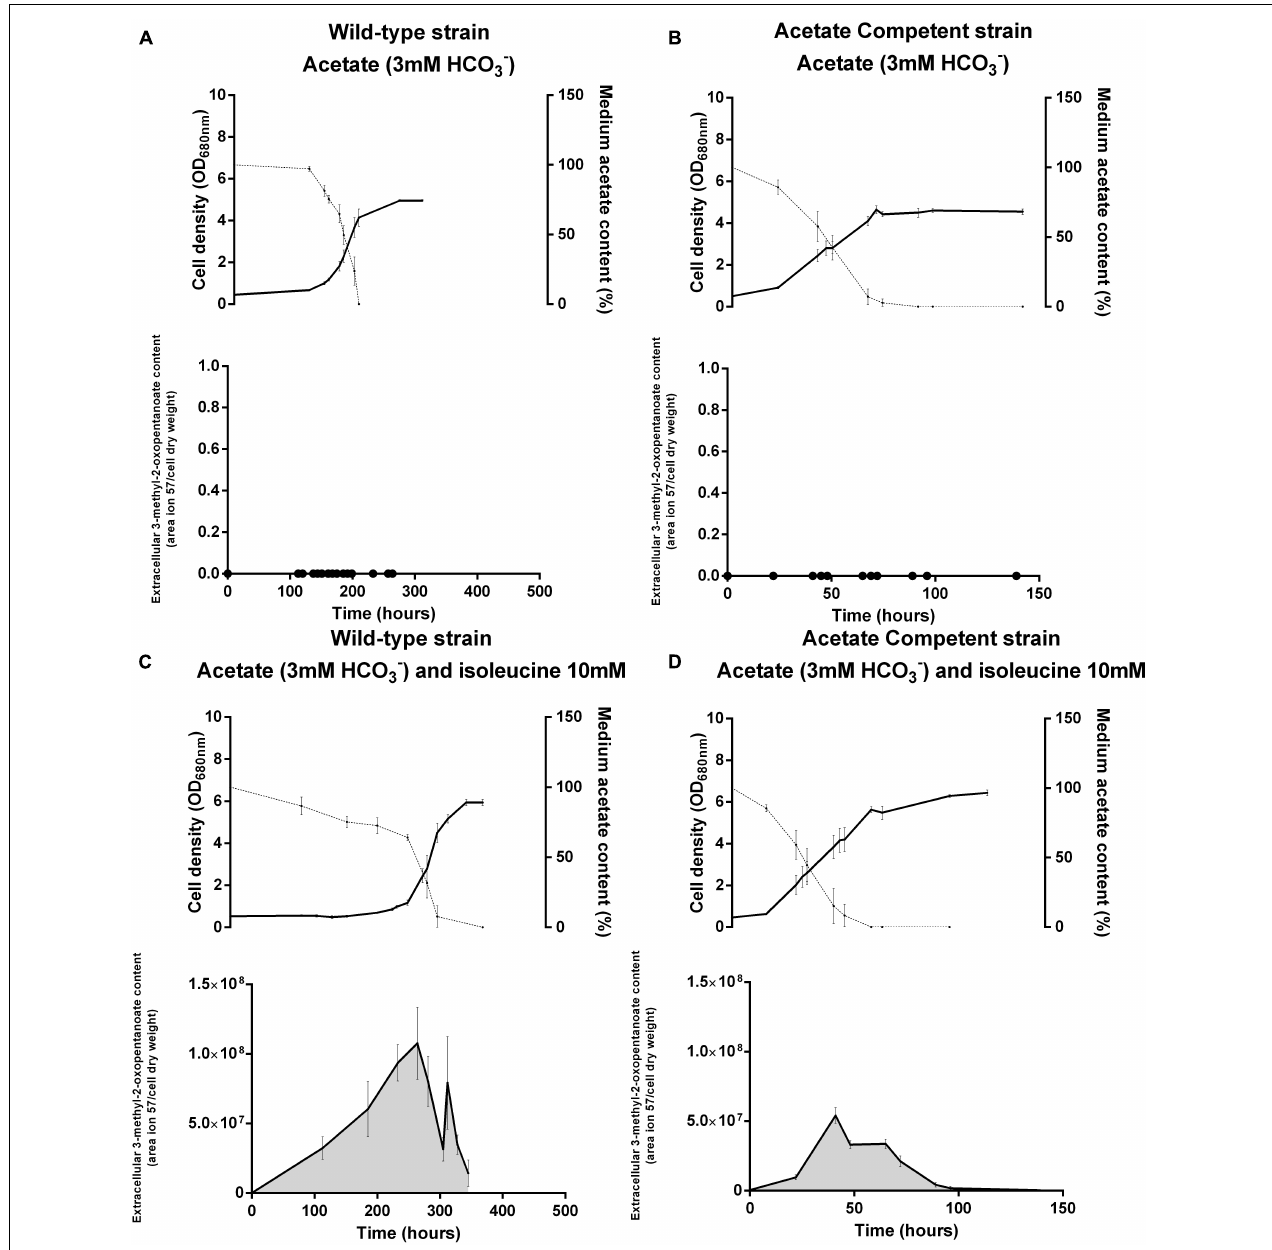
FIGURE 4 | Rhodospirillum rubrum wild-type (A,C) and acetate competent (B,D) strains cultivated in the presence of acetate with (C,D) or without (A,B) 10 mM of isoleucine. Upper panels represent the growth ( full lines ) and acetate consumption ( dotted lines ) and lower panels represent the content of 3-methyl-2-oxopentanoate in the medium. N = 5. Results are represented as the mean ±